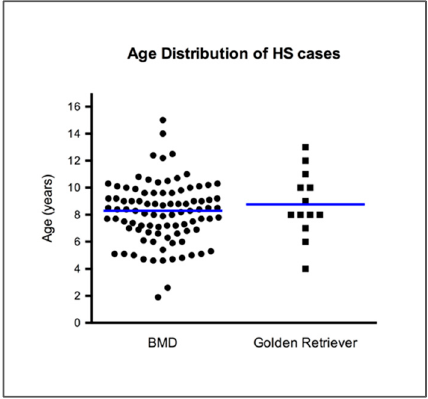
Figure 2. Age distribution in years of cases of histiocytic sarcoma (HS) from Bernese mountain dogs (BMDs) and golden retrievers. Blue horizontal lines represent the median age value.